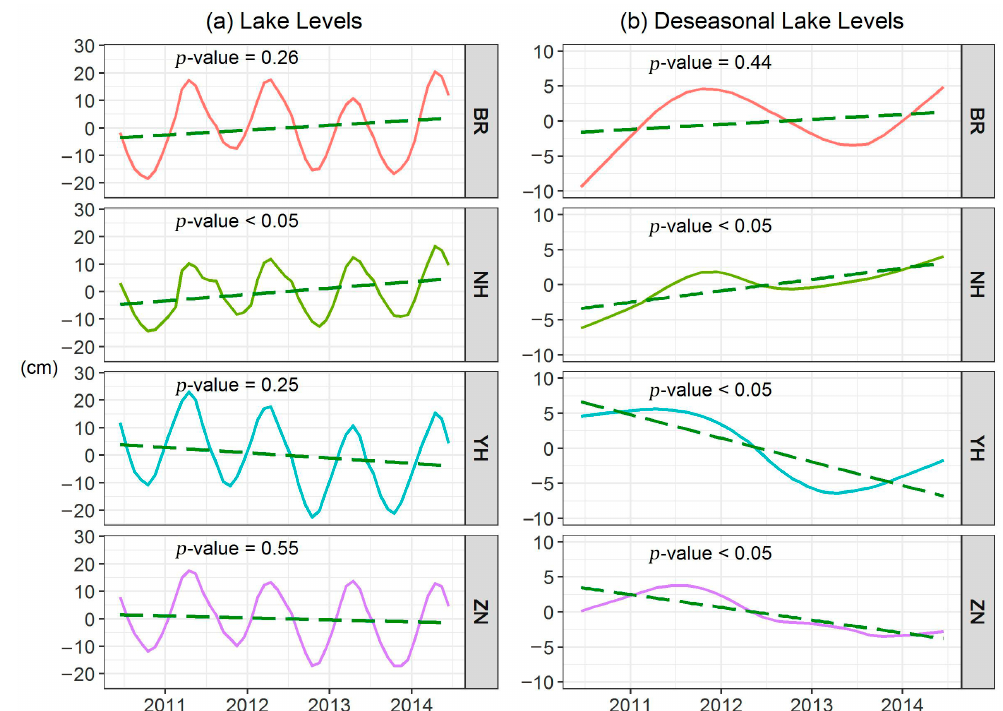
Figure 10. ( a ) The aggregated monthly in-situ lake water levels of the four lakes (Lake BR, Lake NH, Lake YH, and Lake ZN) from June 2011 to June 2015; ( b ) The deseasonalized lake water levels of the four lakes during the observation period with the green dashed lines representing the linear trends of lake water levels.